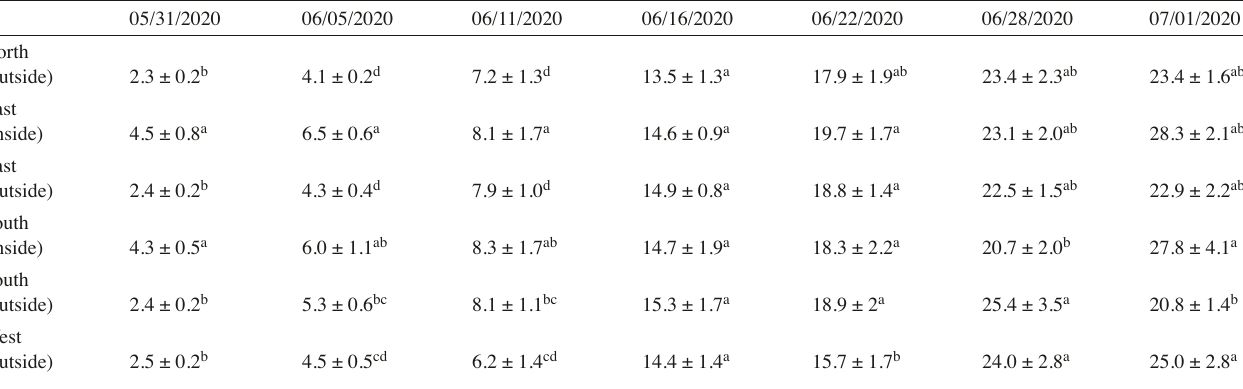
Tab. 1: Average height of kale plants in cm, grown between 31.05.2020 and 01.07.2020. Different letters indicate significant differences of means according to Tukey’s test ( p ≤ 0.05).